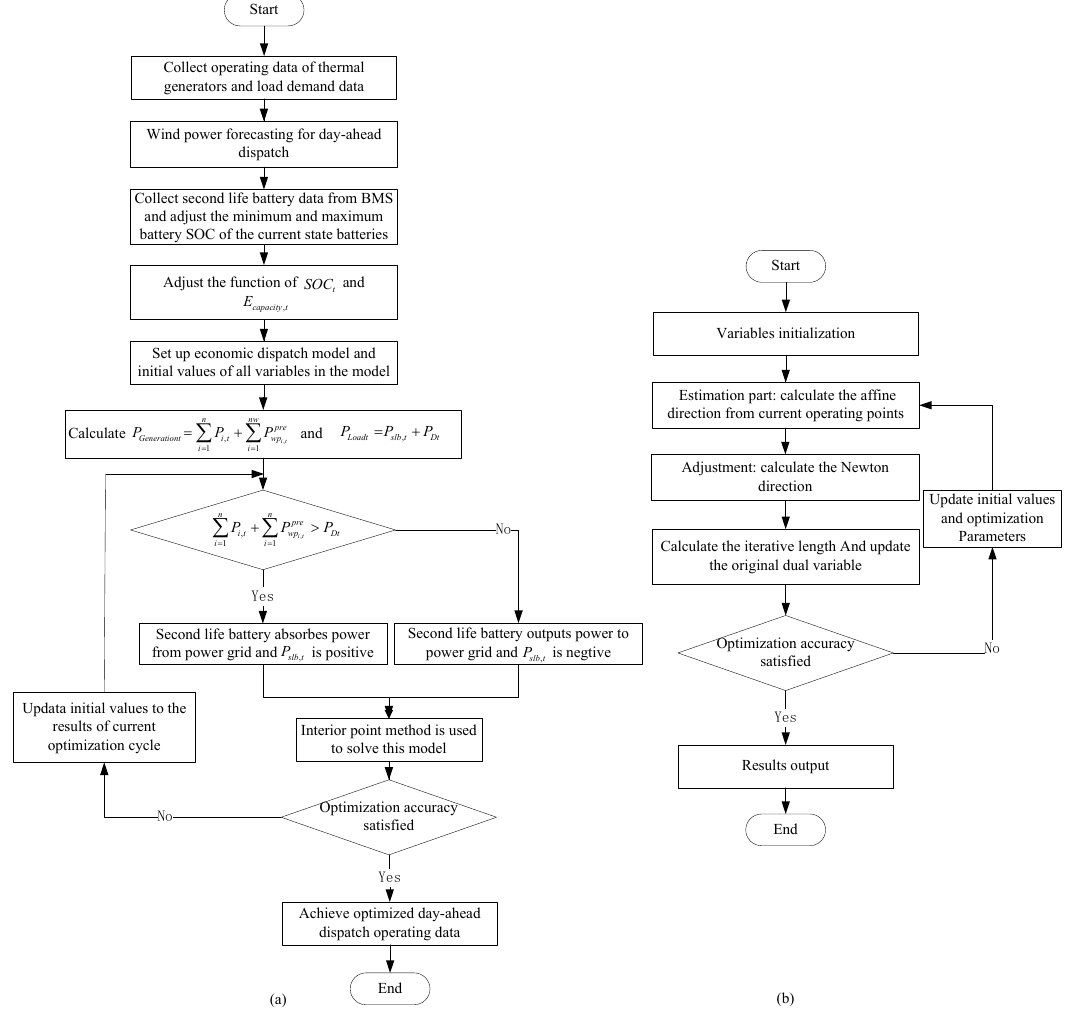
Figure 6. Flow charts. ( a ) is the flow chart of economic dispatch optimization and ( b ) is the flow chart of Interior point method.